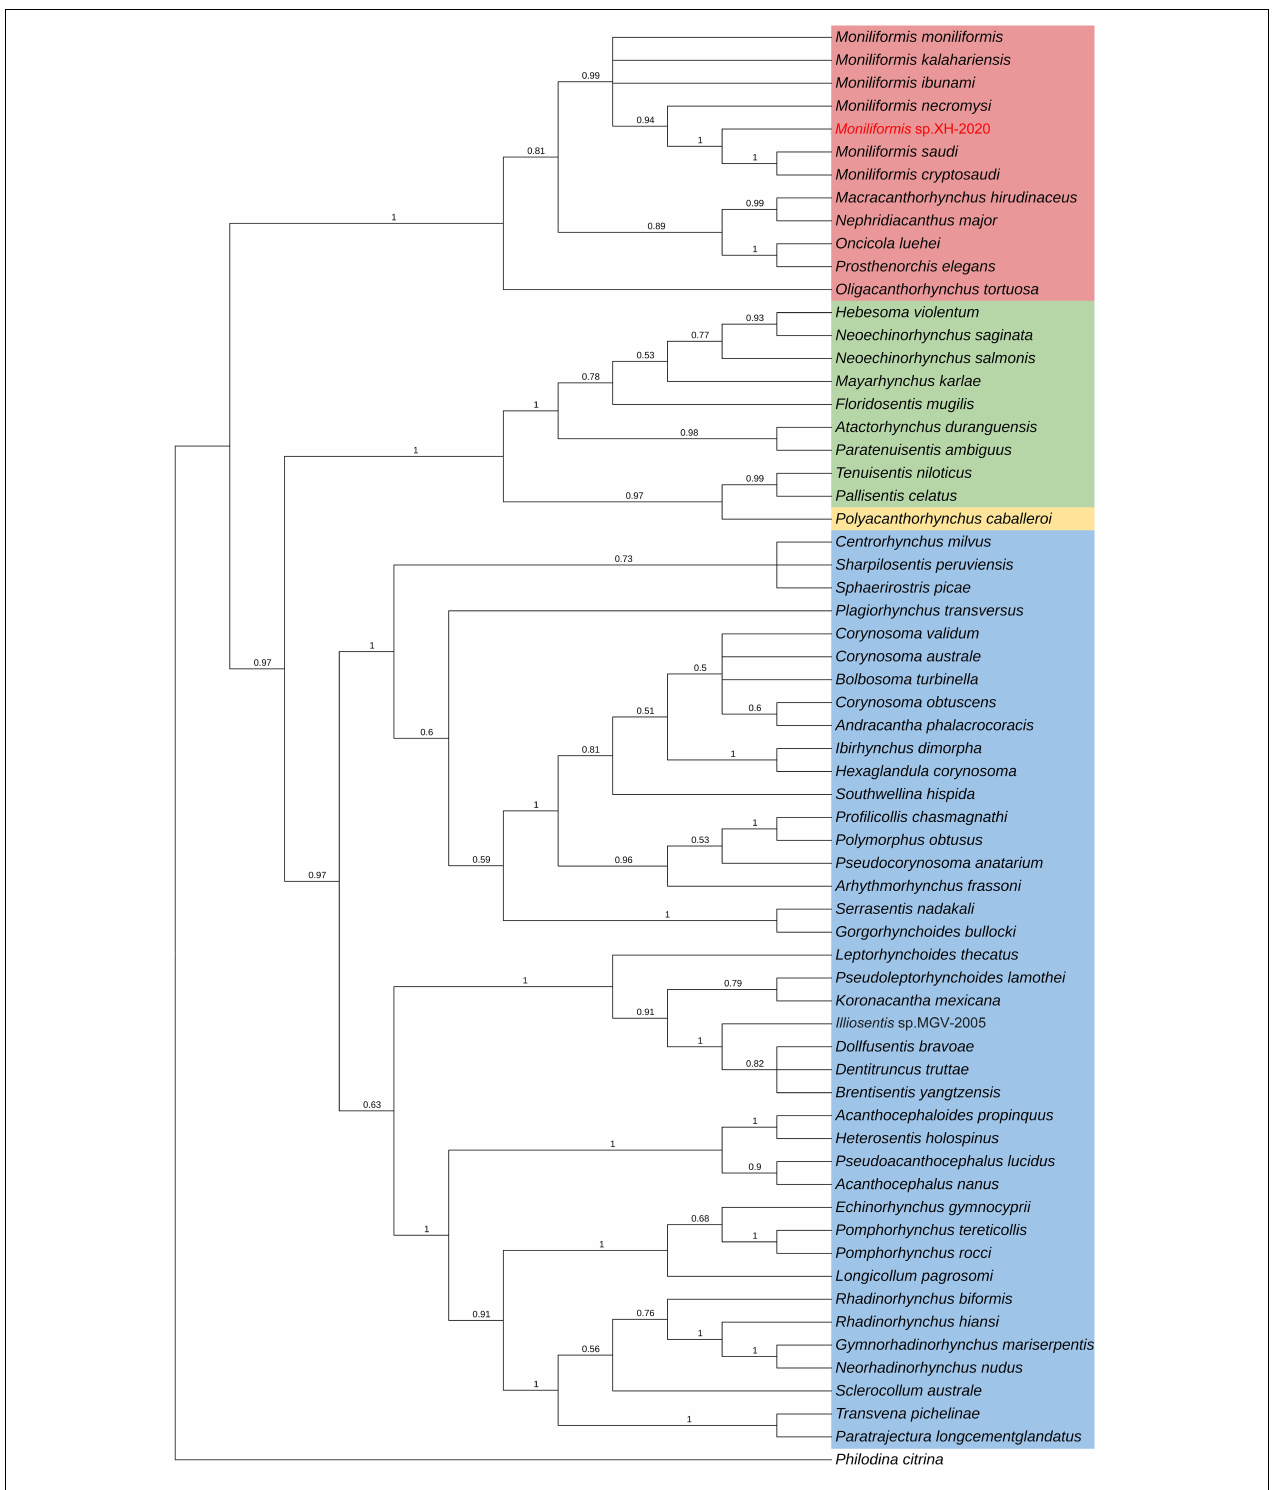
FIGURE 4 | Phylogenetic relationship of Moniliformis sp. XH-2020 with other acanthocephalans based on cox 1 gene by Bayesian inference. Node values are Bayesian posterior probabilities (BPP), the red color indicates the class Archiacanthocephala, the green color indicates the class Eoacanthocephala, the blue color indicates the class Palaeacanthocephala and the yellow color indicates the class Polyacanthocephala.